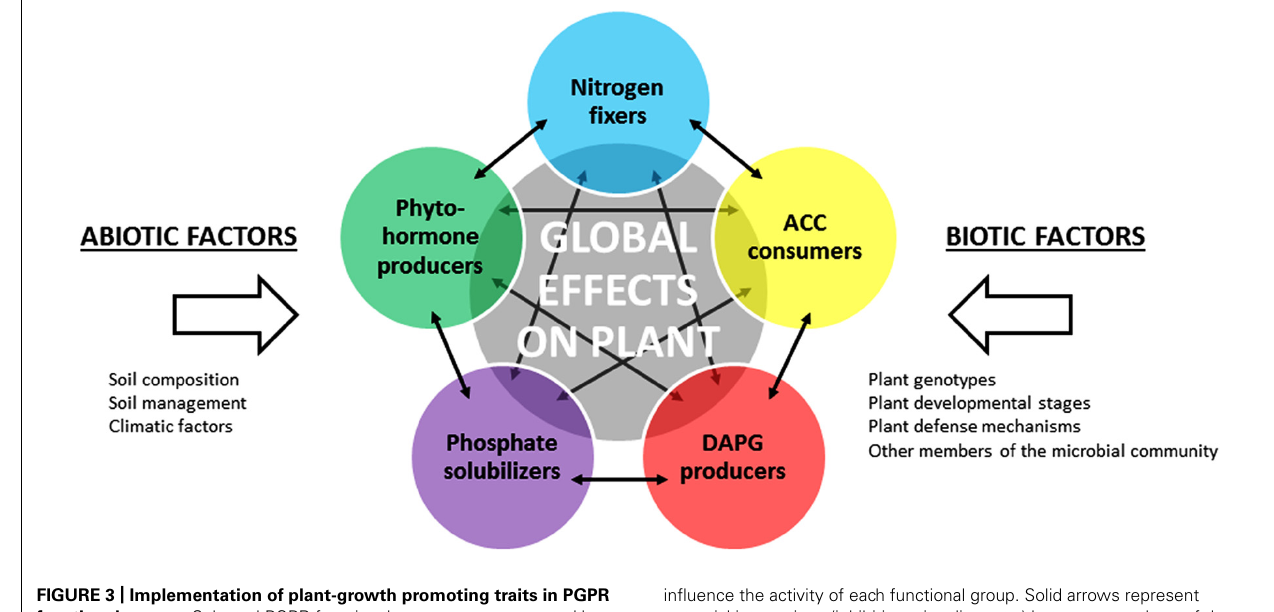
FIGURE 3 | Implementation of plant-growth promoting traits in PGPR functional groups . Selected PGPR functional groups are represented by different colored circles.The resulting effect of all PGPR functional groups on the plant is symbolized by the gray circle. Abiotic and biotic factors may